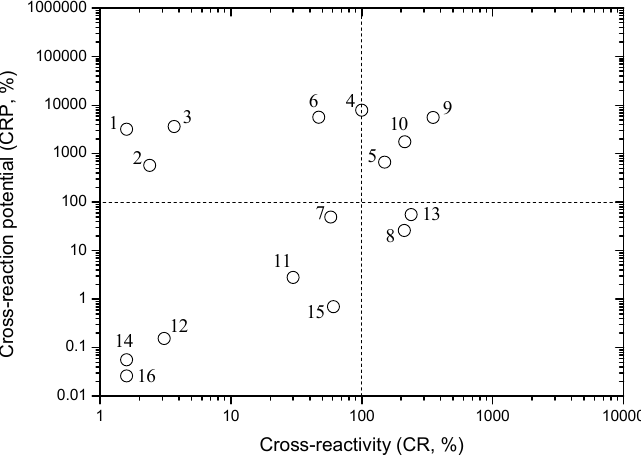
Figure 3. Cross-reaction potential (CRP) and cross-reactivity (CR) of 16 PAHs for RaPID ELISA kit.